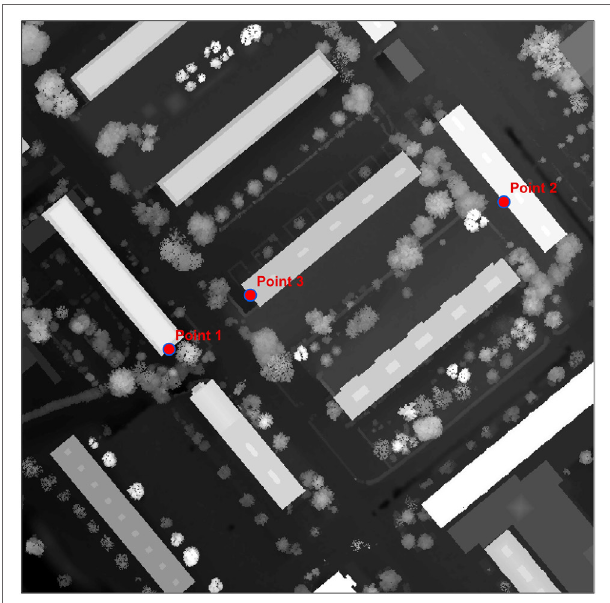
FIGURe 14 | Location of the three points tested in the case-study area of